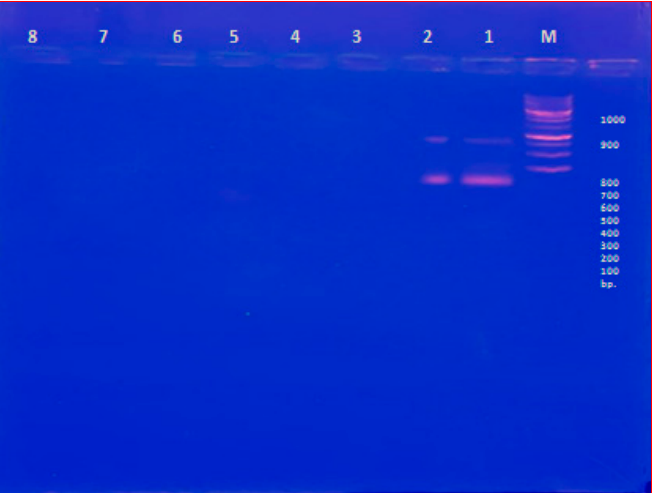
Figure 5. Agarose gel electrophoresis of RT-PCR products of in vitro regenerated plantlets after (CS- NPs) treatment. M 100 bp DNA ladder (Lanes 1 positive control, Lane 2: 100 mg L − 1 , Lanes 3 and 4: